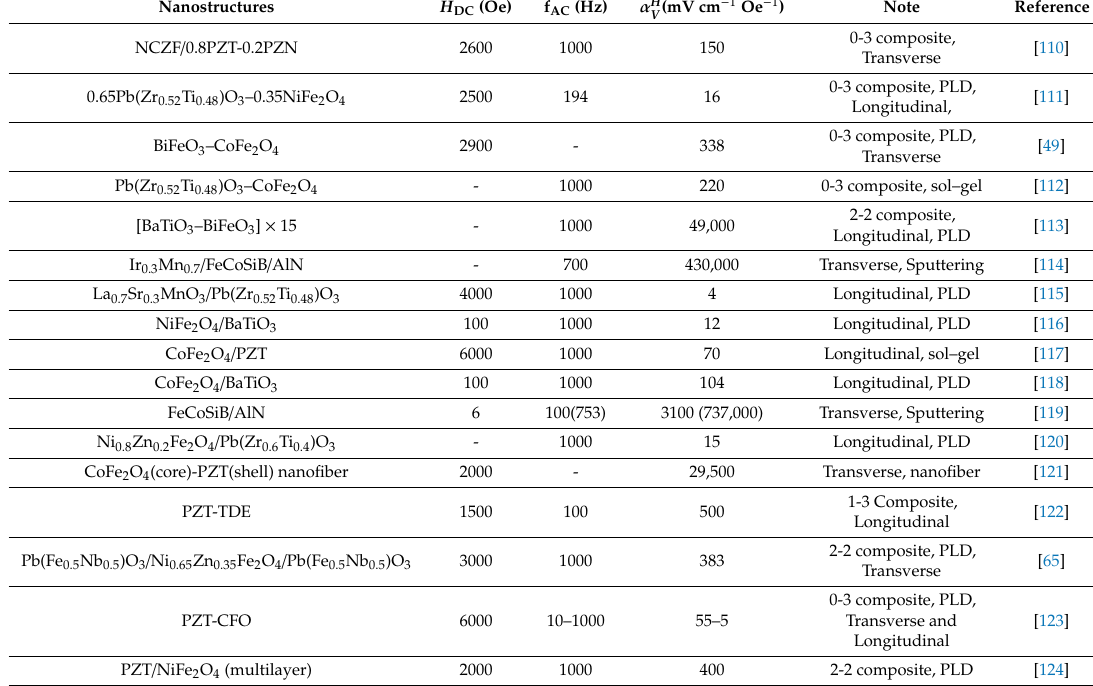
Table 2. Room-temperature α HV value of nanostructured magnetoelectric